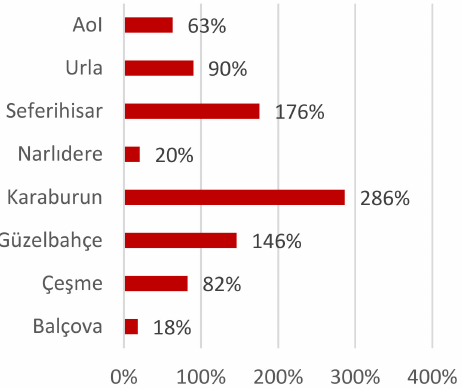
Figure 3. Population changes in the districts of AoI (2000–2020). Source: TurkStat,